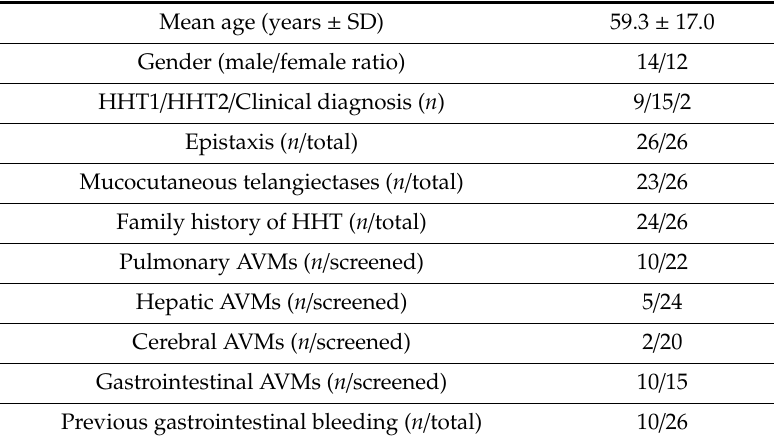
Table 1. Characteristics of the study